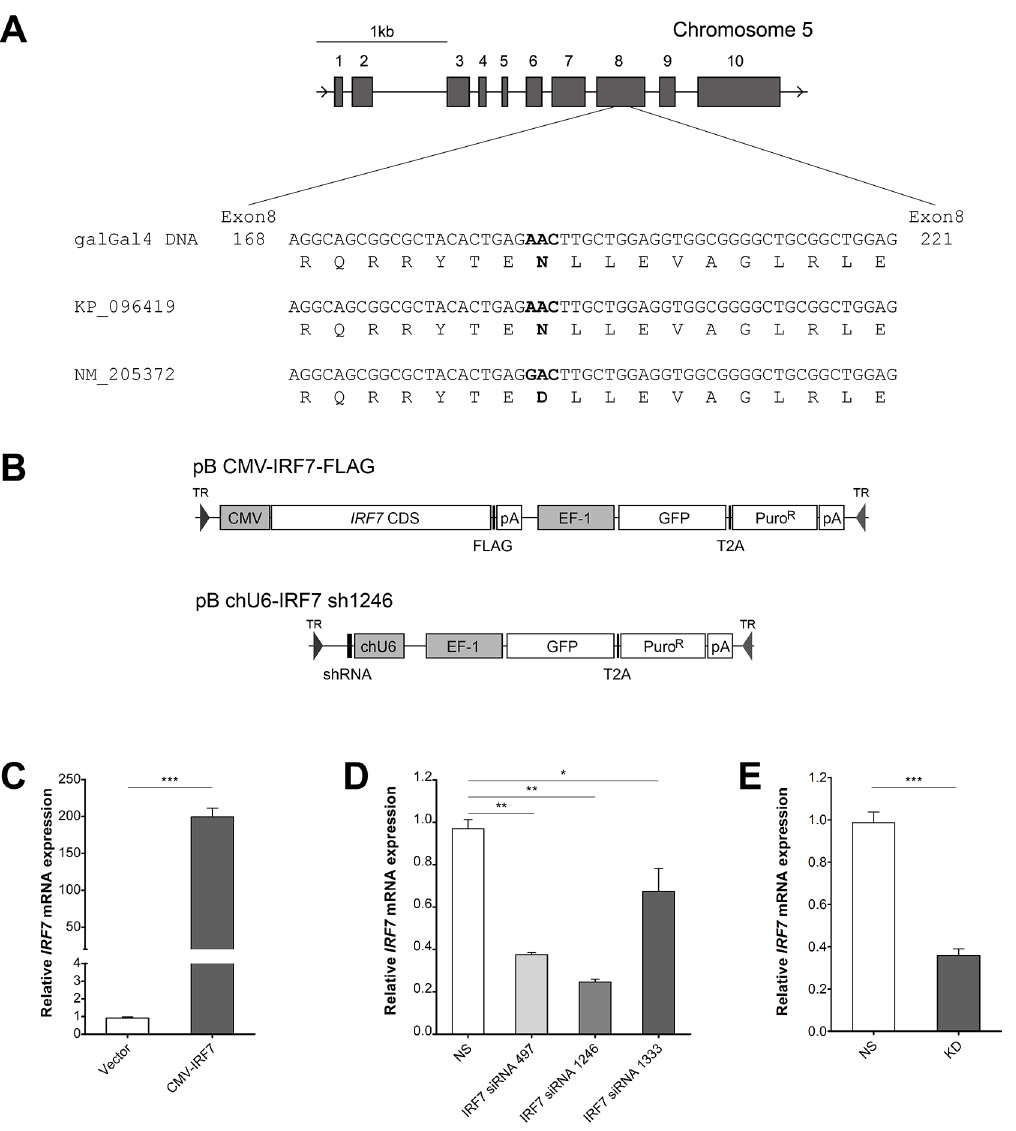
Fig 1. Establishment of IRF7 overexpression and knockdown DF-1 cell lines. (A) Multiple sequence alignment of IRF7 sequences in exon 8 nucleotide position 169 to 221. Molecular cloned IRF7 clone (accession) and the NCBI reference sequence (NM_205372) were aligned against the reference chicken genome (galGal4). (B) Schematic diagram of overexpression (up) and knockdown (down) PiggyBac transposon expression vectors. (C) Related quantitation of IRF7 in control (Vector) and overexpression (CMV-IRF7) cell lines. (D) Knockdown efficiency of each siRNA for IRF7 in the overexpressed cell line. siRNA non-specific (NS) to the chicken genome was used as a control. (E) Knockdown efficiency of IRF7 in the knockdown cell line (KD) as compared to control cells (NS). * P < 0.05, ** P < 0.01, *** P < 0.001. Error bars indicate the SEM of triplicate